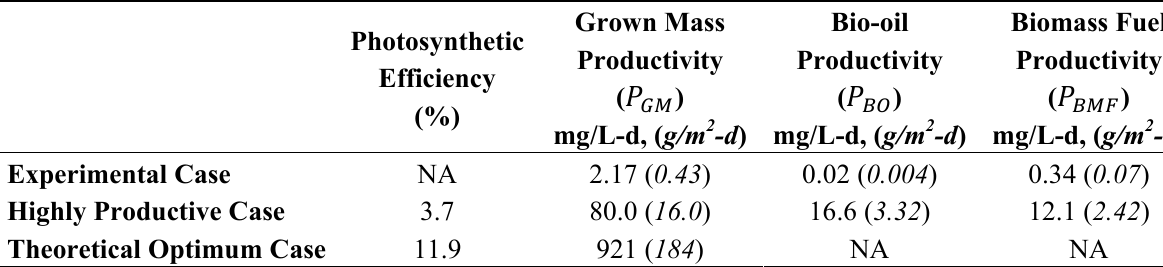
surface area. Culture depth is assumed to be 0.2